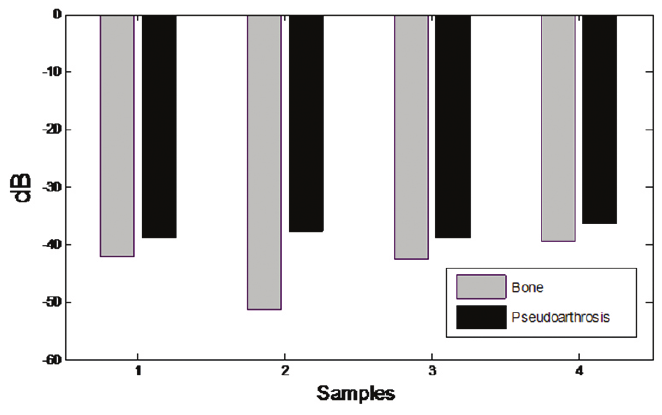
FIGURE 8 - AIB values for pseudarthrosis and the adjacent normal bone of four samples. Significant differences between AIB values for normal bone and pseudarthrosis were found (p =